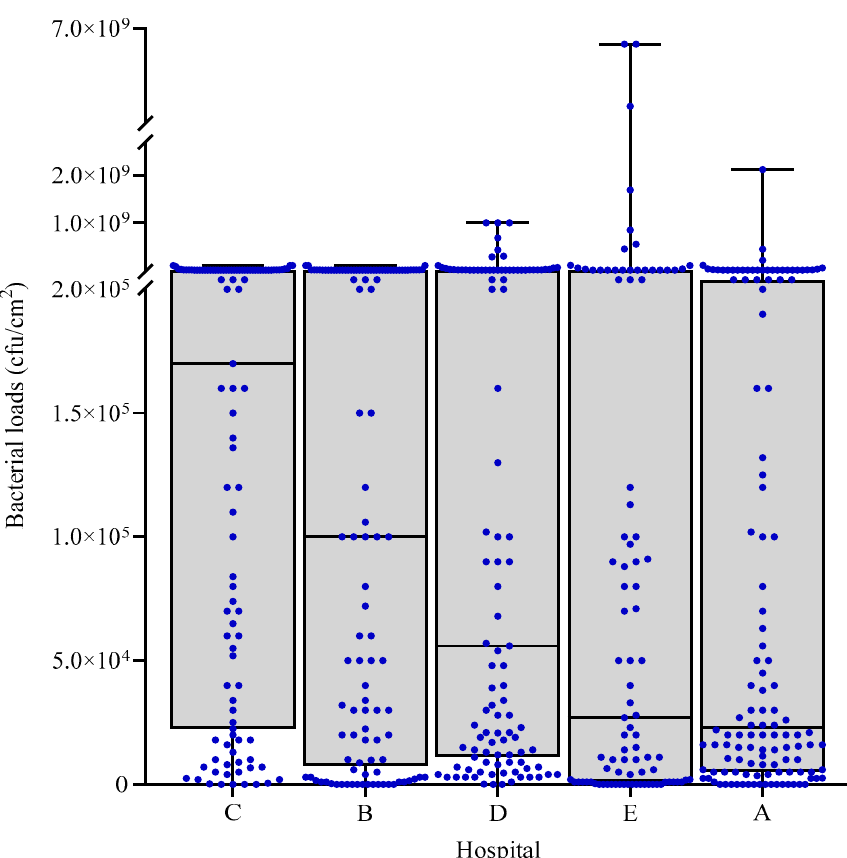
Figure 1. The bacterial load distribution among the study hospitals; in hospitals C and B, the bacterial loads are disbursed throughout the range, while in hospitals A, D, and E, the bacterial loads were mostly greater than 2.0 × 10 5 and/or fewer than 5.0 × 10 4 .